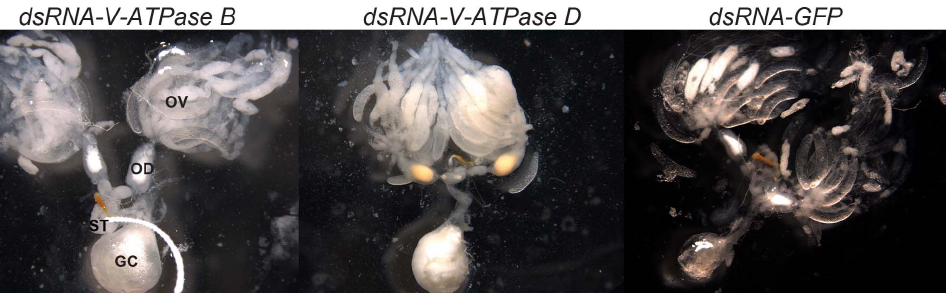
Figure 6. The effect of RNAi of V-ATPases on P.maidis female reproductive organs. ( A–C ) Young adult insects were injected with 250 ng dsRNA of V-ATPase B, V-ATPase D, and GFP . ( A and B ) The V-ATPase B and V-ATPase D dsRNA injected females have deformed ovaries full of fat tissues, and a few deformed oocytes. ( C ) Insects injected with dsRNA of GFP had ovaries that were full of developed oocytes. OV, ovary; OD, oviduct; ST, spermatheca; GC, genital chamber.